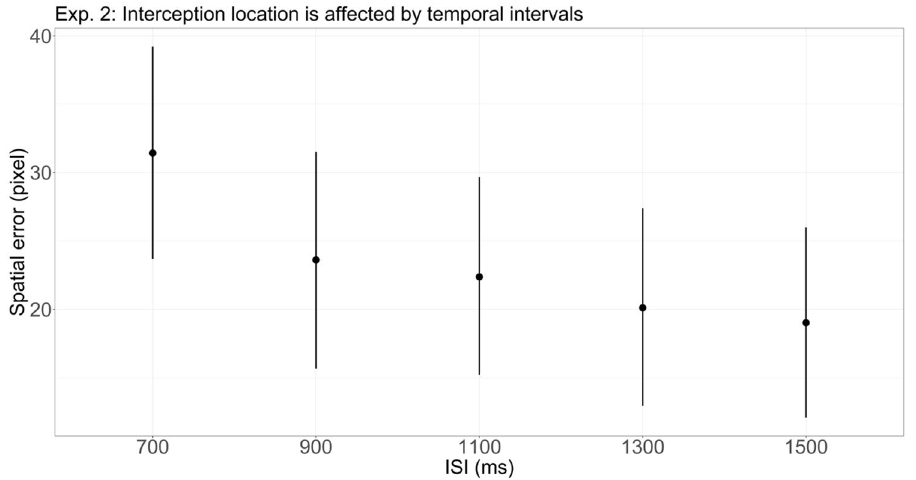
Figure 3. Model estimates (mean and 95% CrI) of the spatial error for different interstimulus intervals (ISIs) in Exp. 2. Positive values indicate that the response overshot the to-be-intercepted final location of the circle. Participant’s response location shifted toward the left side the longer the ISI.